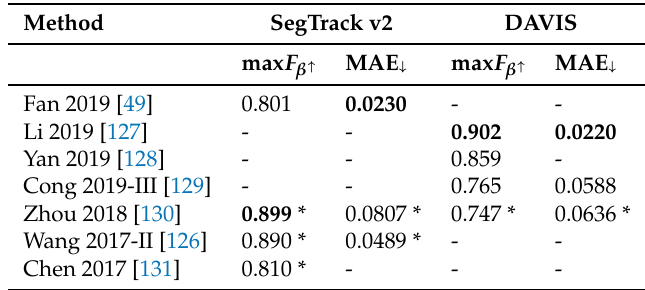
Table 12. Quantitative comparison of selected methods for video saliency estimation on the SegTrack v2 and DAVIS datasets. Best results are highlighted in